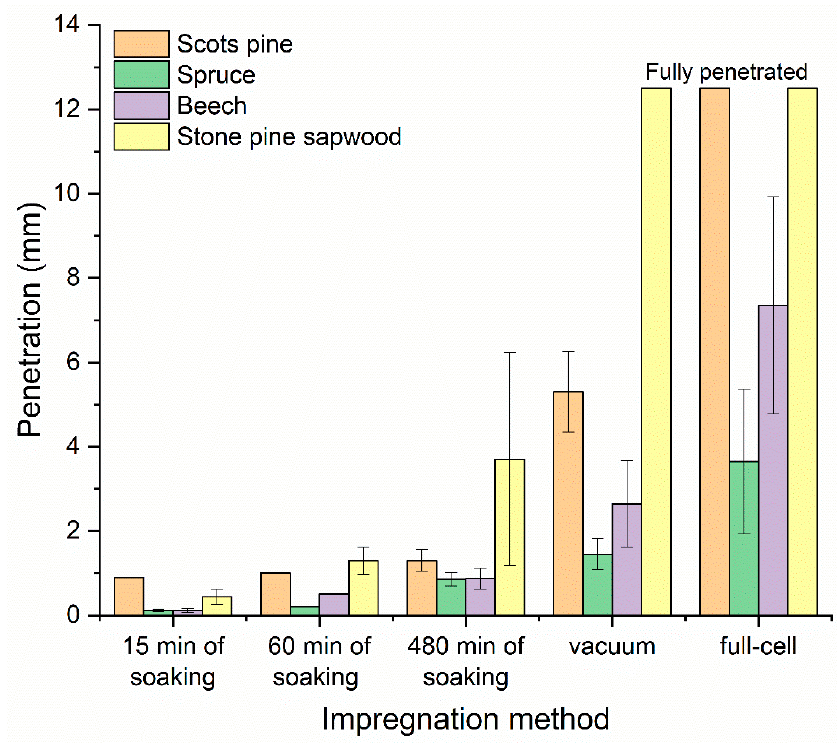
Figure 1. Radial and tangential penetration of Silvanolin preservative solution for the different im- pregnation methods. impregnation